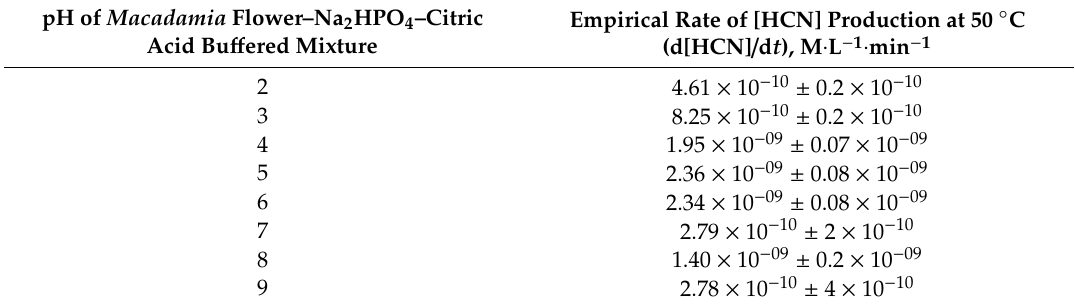
Table 1. Empirical rates of [HCN] production of Macadamia flower treated with Na 2 HPO 4 –citric acid mixture bu ff ered at di ff erent pH and heated at 50 ◦ C for 60